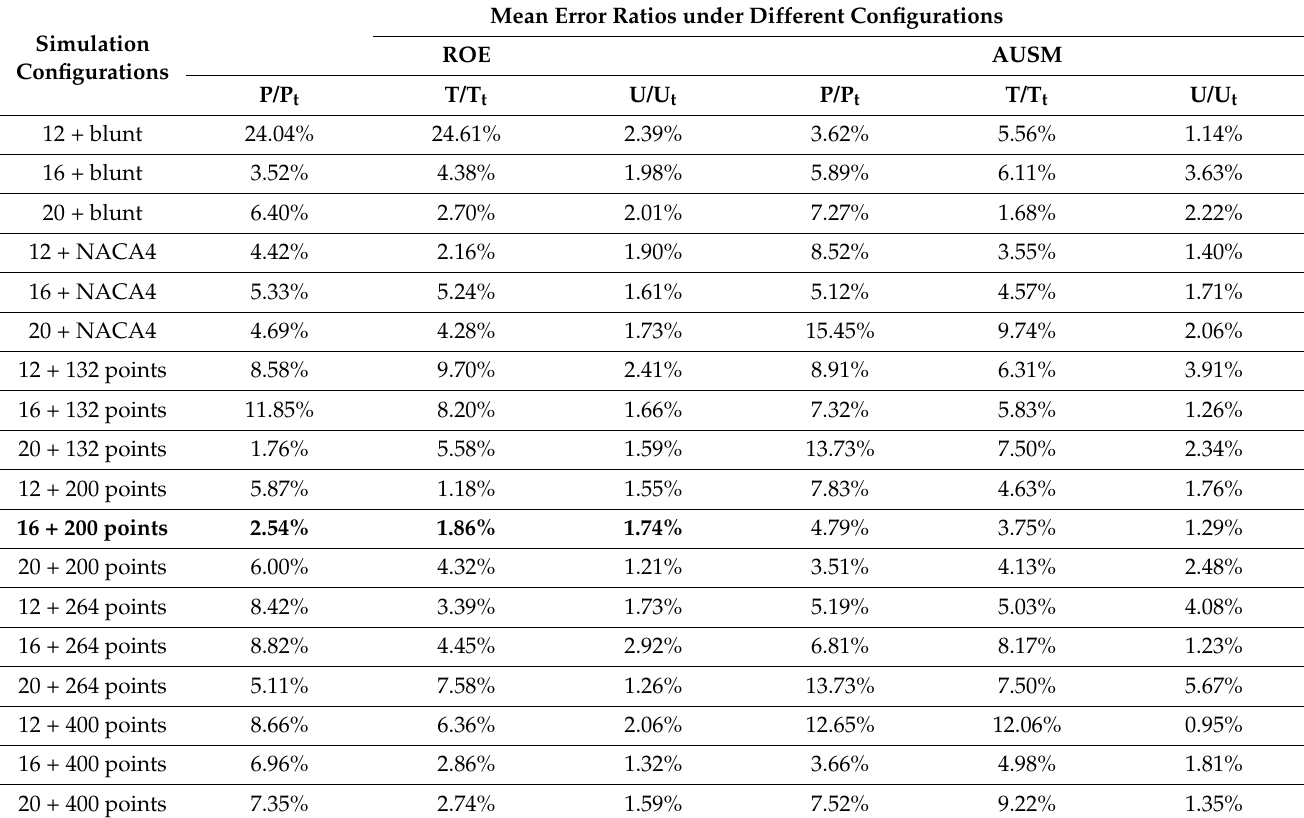
Table 22. The mean error ratios of P/P t , T/T t , and U/U t of SA turbulence model.